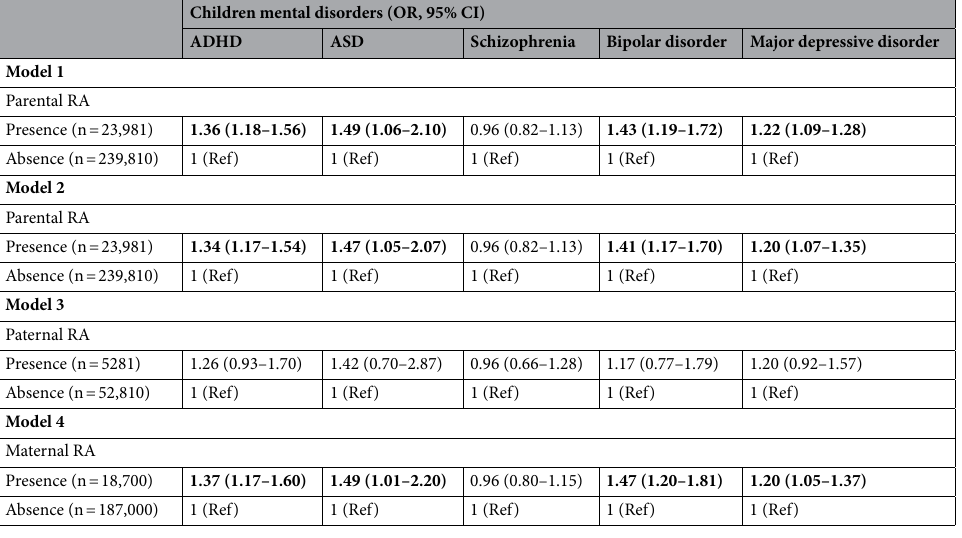
Table 2. Logistic regression on associations between parental rheumatoid arthritis and mental disorders of their children. Model 1: data from both parents, adjusted for demographic data (income, residence); Model 2: data from both parents, adjusted for demographic data, prevalence of parental mental disorders and offspring RA. Model 3: data from only fathers, adjusted for demographic data, prevalence of parental mental disorders and offspring RA. Model 4: data from only mothers, adjusted for demographic data, prevalence of parental mental disorders and offspring RA. Note: bold figures indicate statistical significance. Abbreviations: RA rheumatoid arthritis, OR odds ratio, CI confidence interval, ADHD attention-deficit/hyperactivity disorder , ASDs autism spectrum disorders, Ref